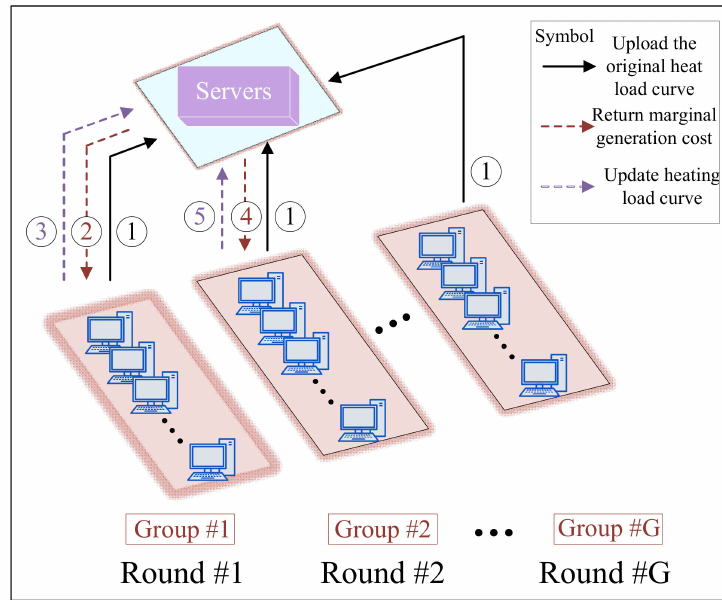
Figure 7. Interactive process of coordinated preheating.